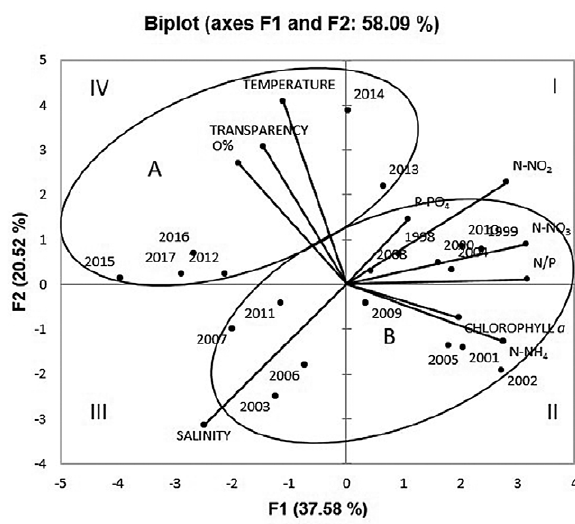
Fig. 5. – Principal component analysis (PCA R-mode): the space is divided into four quadrants (I–IV) to facilitate interpretation; cluster A, years 2012-2017; cluster B, years 1998-2011. Data are shown as annual